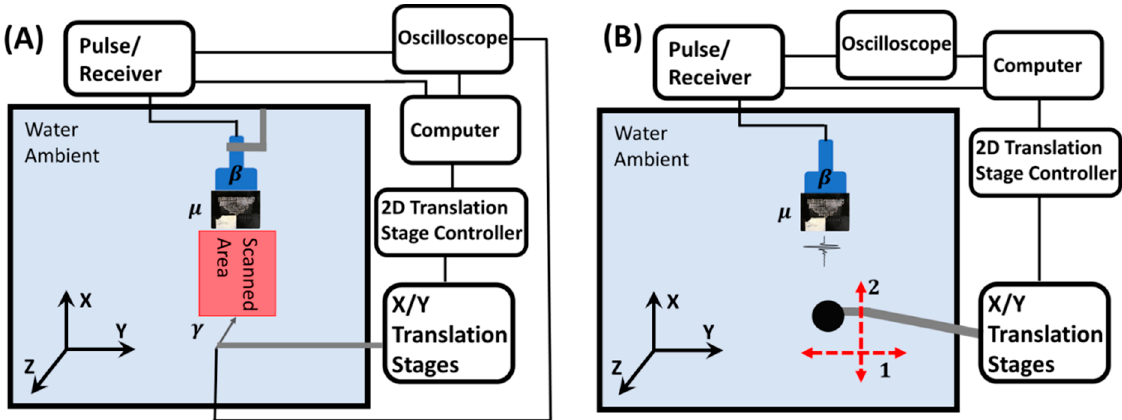
Figure 7. ( A ) Experimental setup of sound pressure field raster scan. ( B ) Experimental setup of monostatic frequency echo- intensity and time domain time-of-flight modes mappings in both 1D and 2D. One-dimensional detection was performed by moving the sample along arrow 1 ( X -axis). 2D mapping was achieved by translating the object in both arrow 1 and 2 ( X - and Y -axis). In the illustrations, β was transducer. µ indicated lens. Arrow γ represented needle hydrophone.